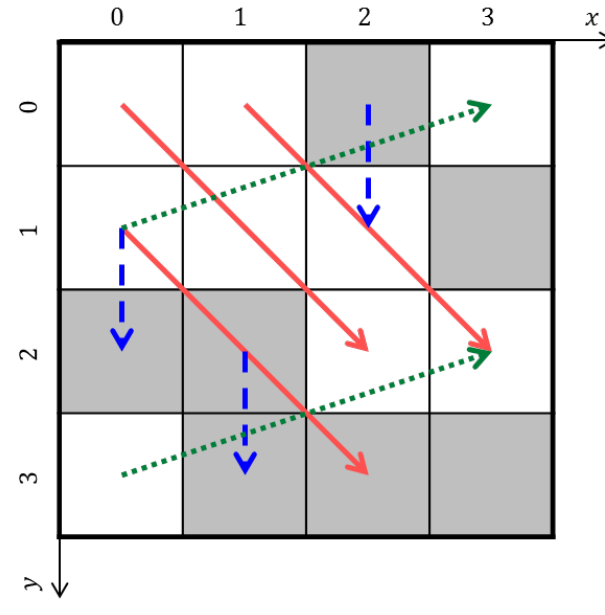
Figure 10. Illustration of two-point correlation.